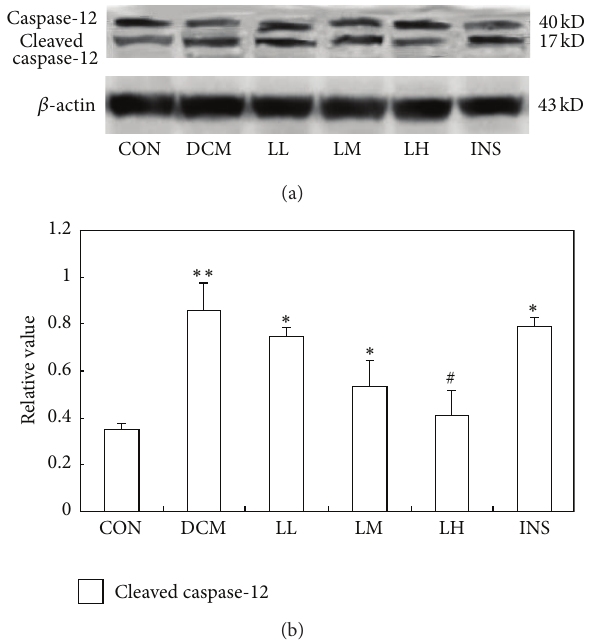
Figure 5: Semiquantification of mRNA levels of the ER stress- associated genes in the DCM and CON. (a) The ATF4, TRAF2, and splicing XBP1 were separated in 1.4% agarose gels. The relative value of each preparation is calculated by the gray numerical value of each specific product versus that of 𝛽 -actin. (b) The average data of each preparation are evaluated based on three independent reactions and represented as mean ± S.D. Statistical differences of the data of each preparation compared with that of CON are illustrated as ∗ 𝑃 < 0.05 and ∗∗ 𝑃 < 0.01 , and of DCM are illustrated as # 𝑃 < 0.05 and ## 𝑃 < 0.01 ,